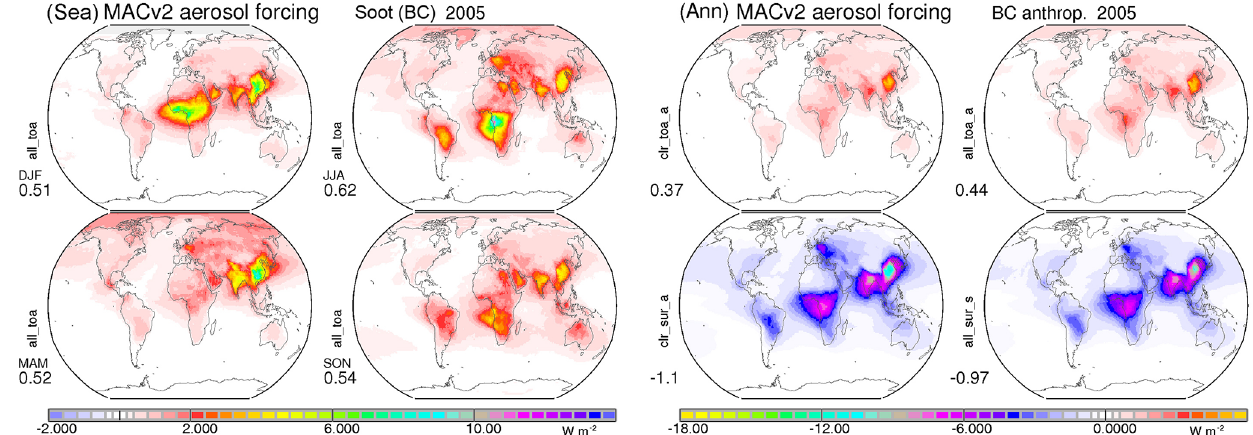
Figure E5. Seasonal maps for present-day total BC radiative TOA all-sky effects (left frame) and annual maps for radiative effects at TOA and surface by enhanced anthropogenic BC contributions (right frame, now with a higher BC anthropogenic fraction of 75% compared to the 50% BC anthropogenic fraction of Fig. E4). Values below the labels are global